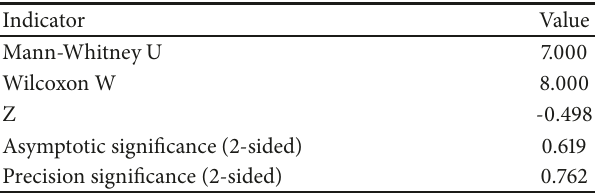
Table 7: Result of significant difference (Mann-Whitney test).